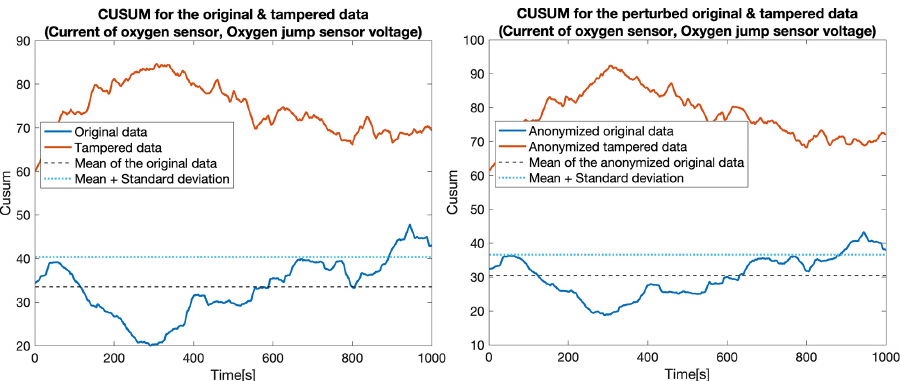
Figure 10. CUSUM for the original data (blue) and tampered data (orange) for sensors: Current of oxygen sensor and Oxygen jump sensor voltage .